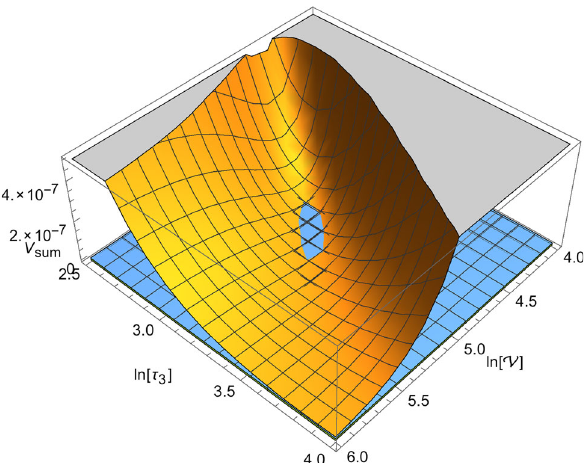
Fig. 2 Sum of the F- and D-term contributions to the potential (37) and (42) in terms of ln ( V ) and ln (τ 3 ) with the choice W 0 = 1, η τ = − 0 . 4 , d = d = 0 . 00375, d = 0 . 0018. The blue area corresponds to 1 2 3 V = 10 − 8